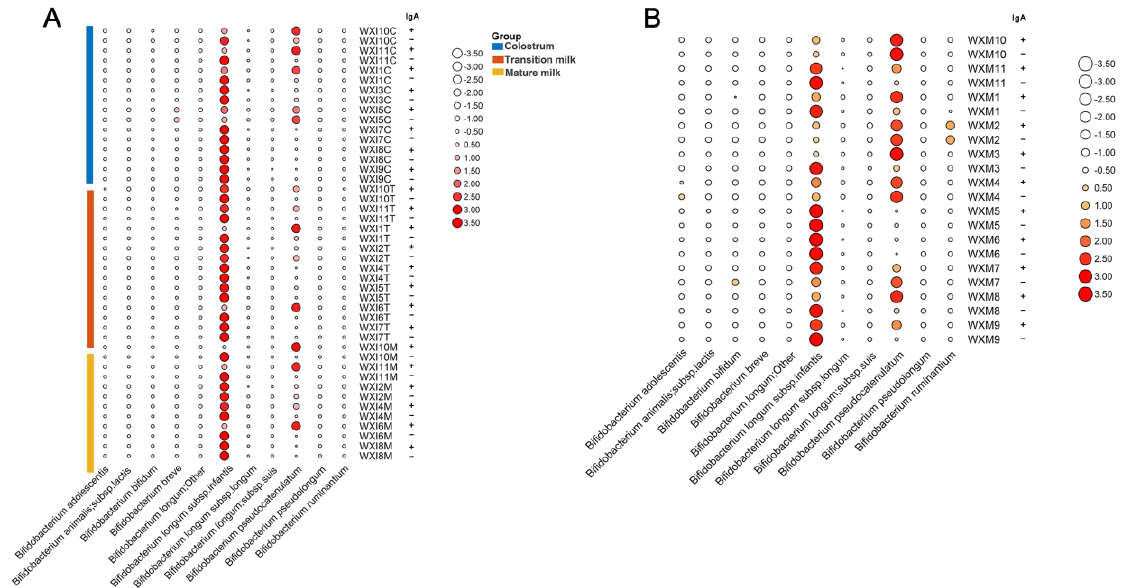
Figure 7. Distribution of sIgA-coated and uncoated Bifidobacterium in each sample of infant ( A ) ma- ternal feces ( B ). The relative abundance of Bifidobacterium was shown in row normal normalized. The greater the relative quantity of Bifidobacterium, the deeper the red hue and the larger the circle. Greater abundance is indicated by larger white circles. IgA+ means IgA-coated bacteria and IgA − means IgA-uncoated bacteria.